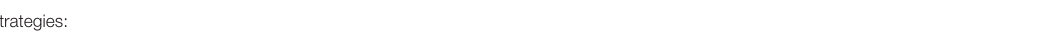
Strategies: · Preparation of a technical reference framework for the protection of mental health and psychosocial support in the context of COVID-19. · Preparation of thematic guidelines for the work of health teams and psychosocial teams in the context of COVID-19. · Preparation of guidelines for remote mental health care strategies for the health network. · Adaptation of the First Psychological Aid model to the context of COVID-19. · Development of dissemination strategies, technical transfer, and training of technical guidelines during COVID-19. · Collaboration in technical transfer and training processes developed by other sectors and civil society organizations. Based on Ministry of Health